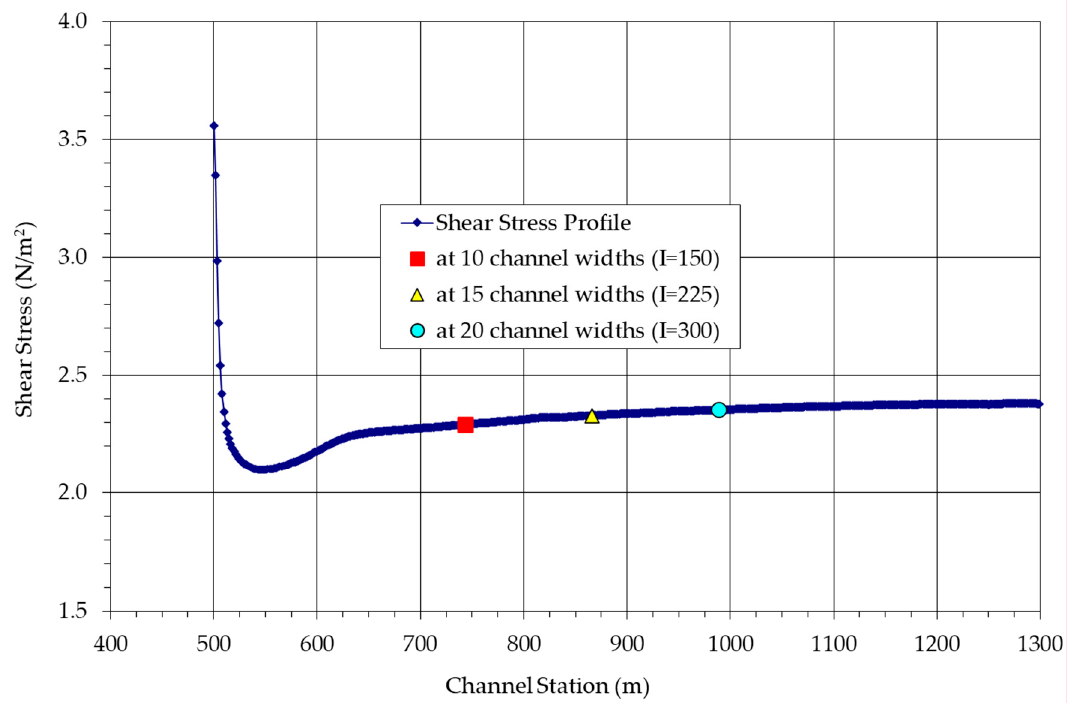
Figure 20. Simulated bottom shear stress long the centerline of a straight trapezoidal channel from Simulation Set 6 (bottom width of 20.3 m).